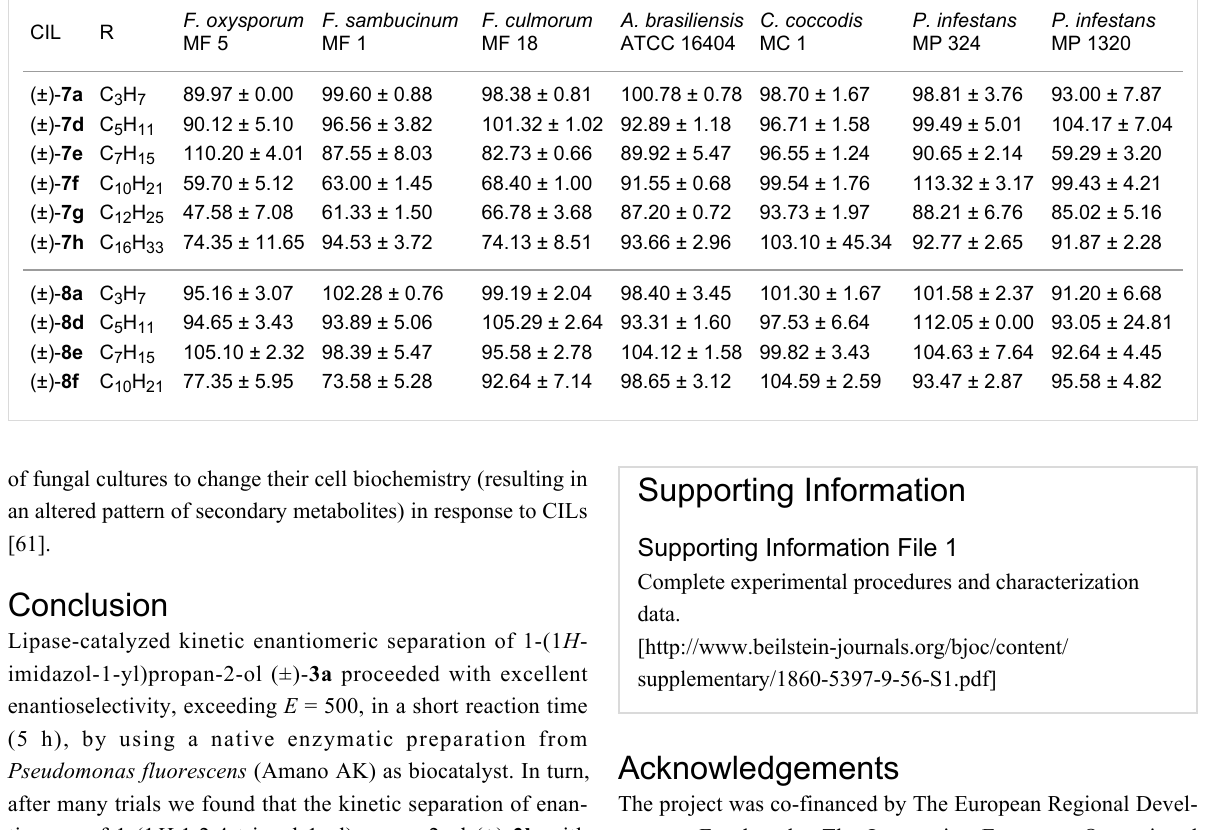
Table 6: Antifungal activity (% of control) of the racemic imidazolium and triazolium CILs (1mM).